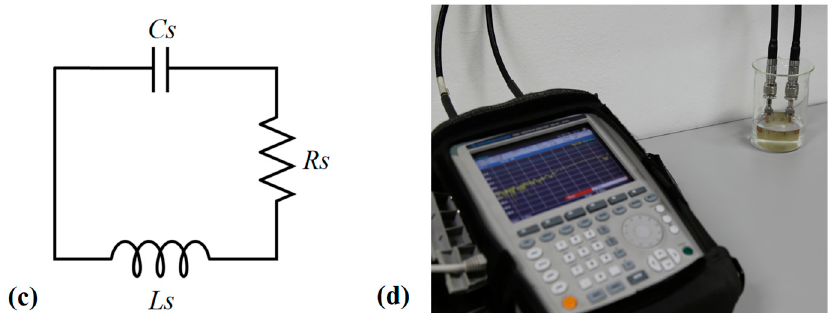
Figure 1. ( a ) Schematic of the proposed sensor device. ( b ) Picture of the sensor device immersed in the material under test (MUT). ( c ) Equivalent electrical circuit of the proposed SRR. ( d ) Sensor’s dipoles connected to the analyzer.